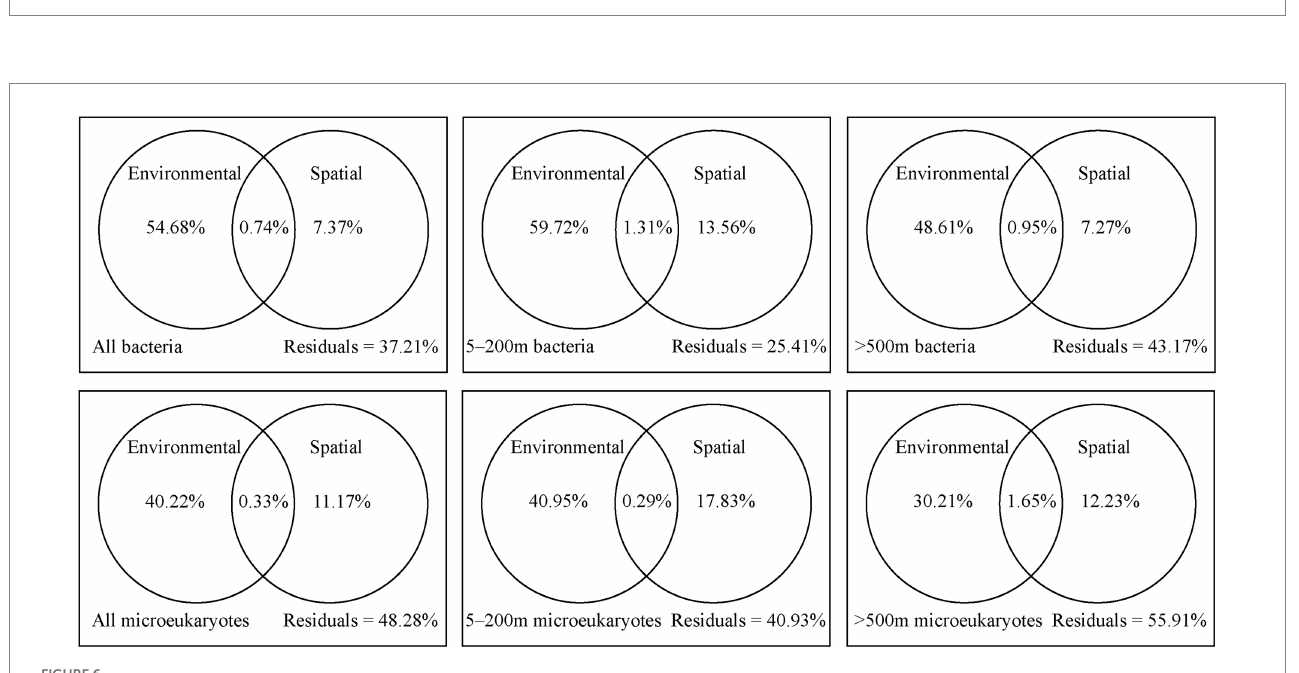
FIGURE 6 Variation partitioning analysis of all, 5–200 m, and > 500 m bacterial and microeukaryotic community composition between environmental and spatial